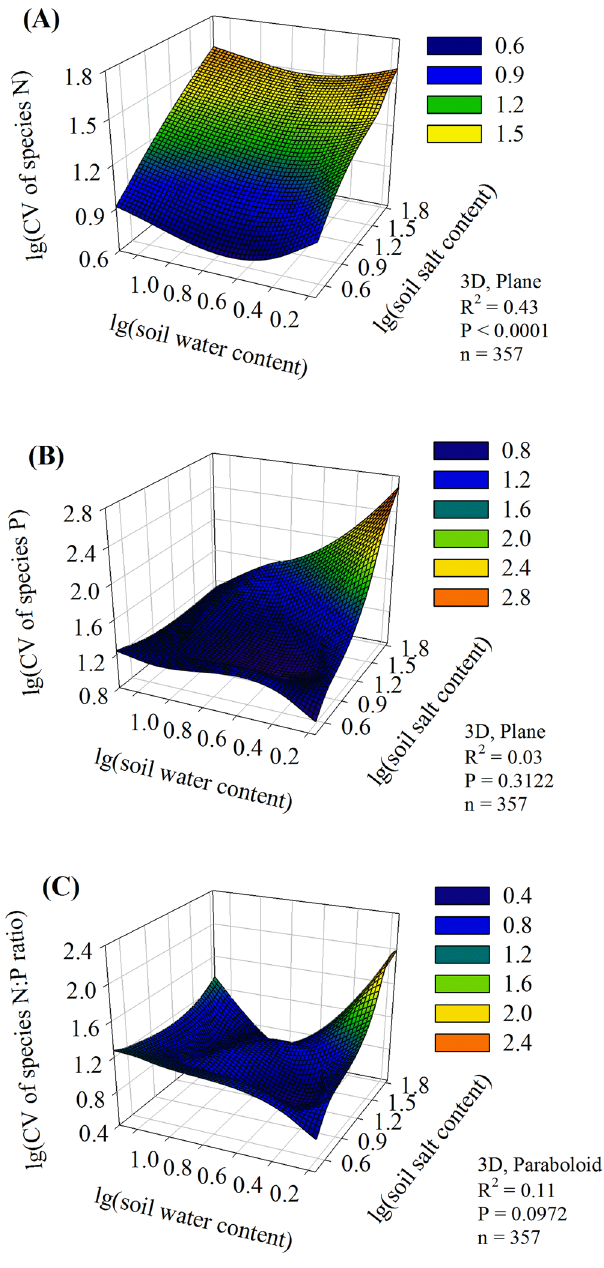
Figure 4. Relationships between coefficient of variance (CV) of species stoichiometry and soil water and salt component analysis (PCA) of the environmental data, sites 1, 2, 3 and 4, sites 5, 6, 7, 8, and 9, and sites S1, S2, S3 and S4 were defined to be dry sites (low soil salt content, see Table 1), humid-saline sites and humid-non-saline sites, respectively (Fig. S2). One-way analysis of variance (ANOVA) was used to examine the differences in leaf N, P (content or concentration) and N:P ratios among all the plants from the dry sites, humid-saline sites and humid-non-saline sites, and differences in soil factors among all the sites. The 3-D mesh plot was also used to show the response trend in coefficient of variance (CV) of the leaf N, P and N:P ratio for each species due to soil water and salt content. We further analyzed the linear or nonlinear relationships based on the regression analysis between each of the community nutrient metrics (N, P and N:P ratio) and both soil water content and salt con- tent. The above statistical analyses were conducted using the statistical package SPSS (PASW statistics 21.0; IBM Corporation, Armonk, NY, USA) and SigmaPlot 12.5 (SyStat Software Inc., San Jose, CA, USA). Variation in com- munity N, P and N:P ratio was partitioned between two explanatory variable groups (soil water content [0–20 cm, 20–100 cm] and soil salt content [0–20 cm, 20–100 cm]) using a partial regression analysis with a redundancy analysis (RDA) 34 . PCA and RDA were conducted using CANOCO 5.0 (Microcomputer Power, Ithaca, NY, USA).